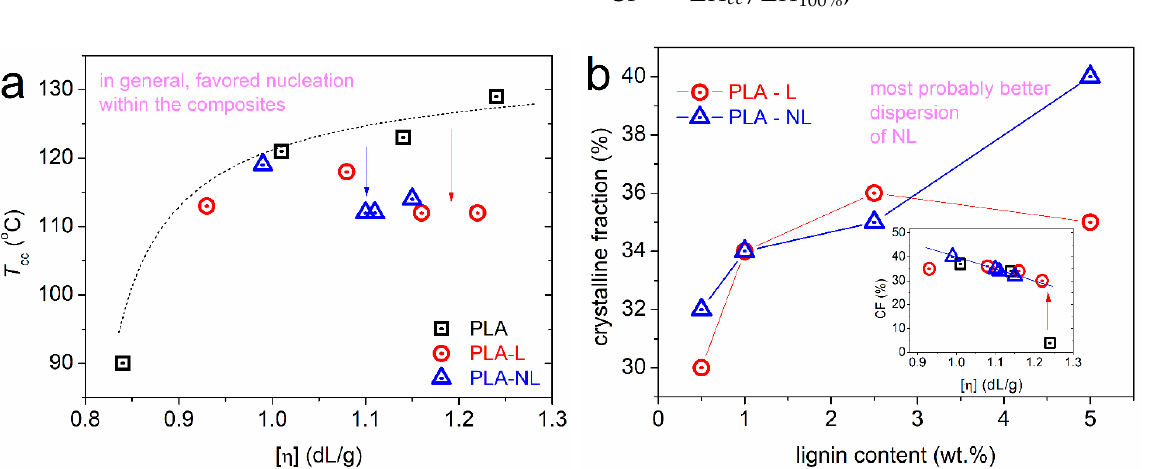
Figure 6. ( a ) The [η] dependence on the cold crystallization temperature for all samples. ( b ) The lignin loading dependence on the crystalline fraction, CF, estimated from cold crystallization. The inset to ( b ) shows the same data for CF as a function of the [η] of the matrix.